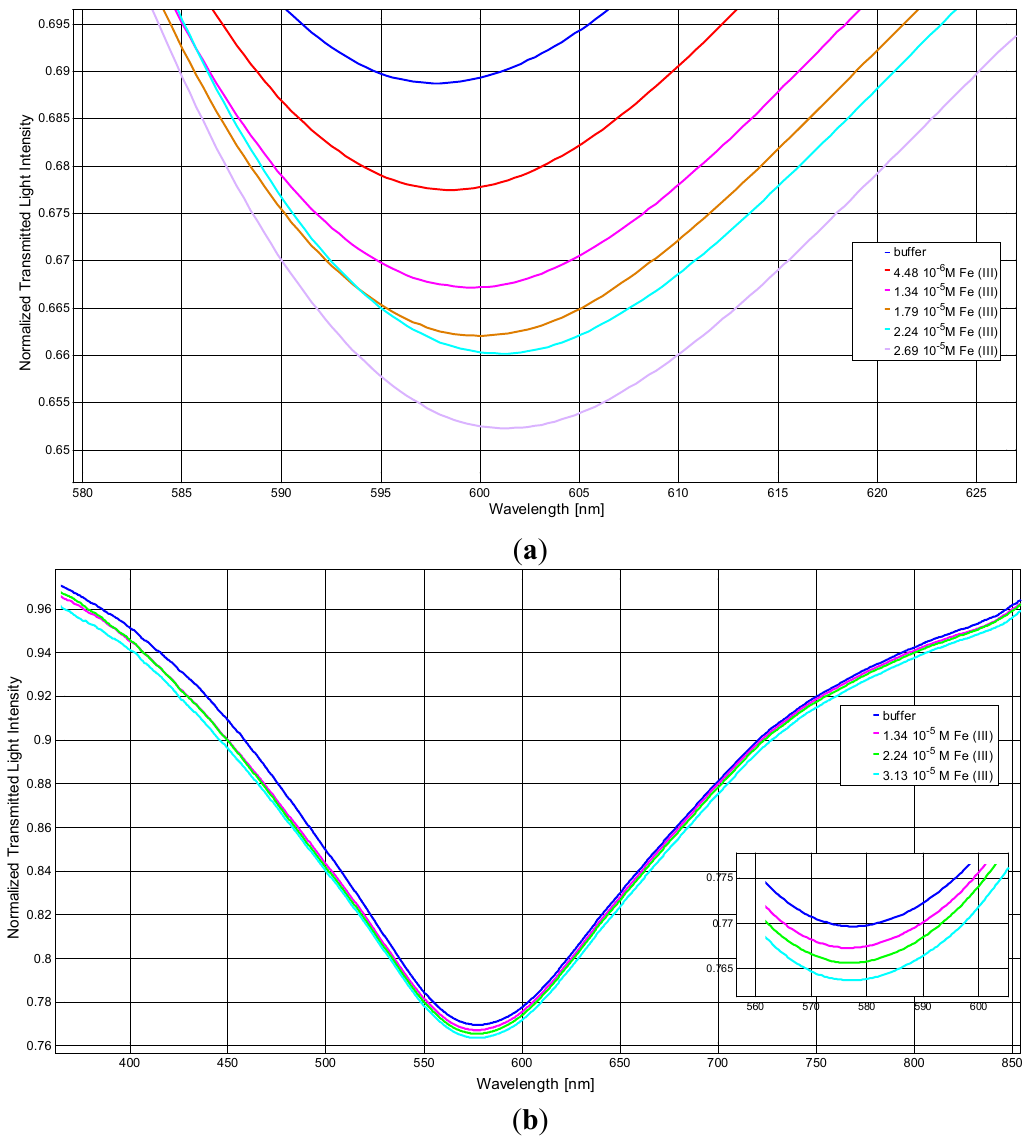
Figure 2. Transmission spectra of DSO-SAM-POF sensor in 0.5% HNO concentration of Fe(III). ( a ) measures with DFO-SAM modified gold layer (DFO-SAM sensor); ( b ) measures with bare gold layer (bare sensor). Inset: Zoom of the resonance wavelengths